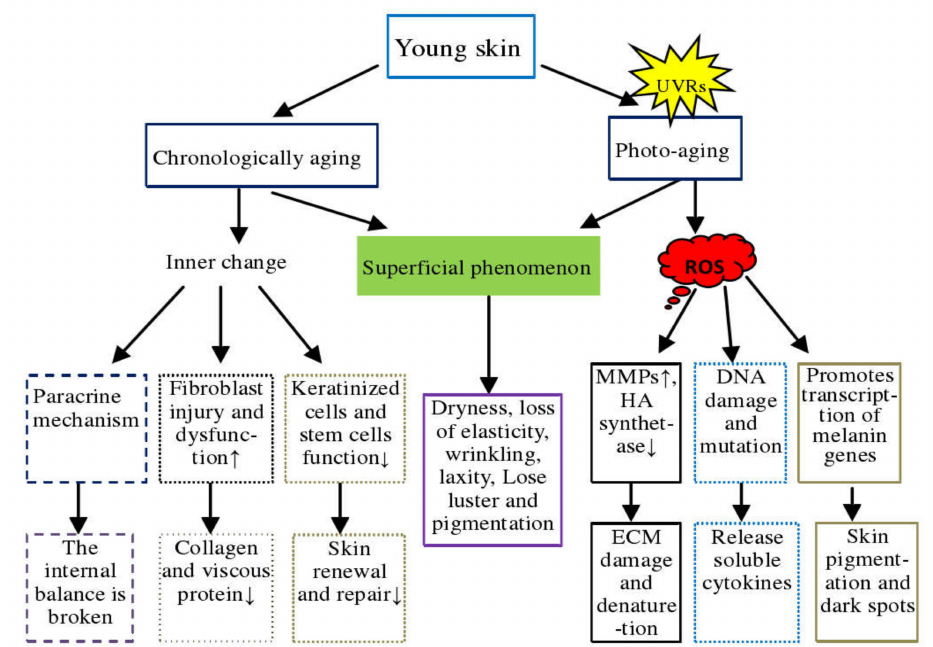
Figure 2. Comparison of chronological aging and photo-aging of the skin. In the figure, " ↑ " means "rise or increase"; " ↓ " means "fall or decrease"; DNA = deoxyribonucleic acid; ECM = extracellular matrix; UVRs = ultraviolet radiations; ROS = reactive oxygen species; MMPs = Matrix metalloproteinases; HA = Hyaluronic